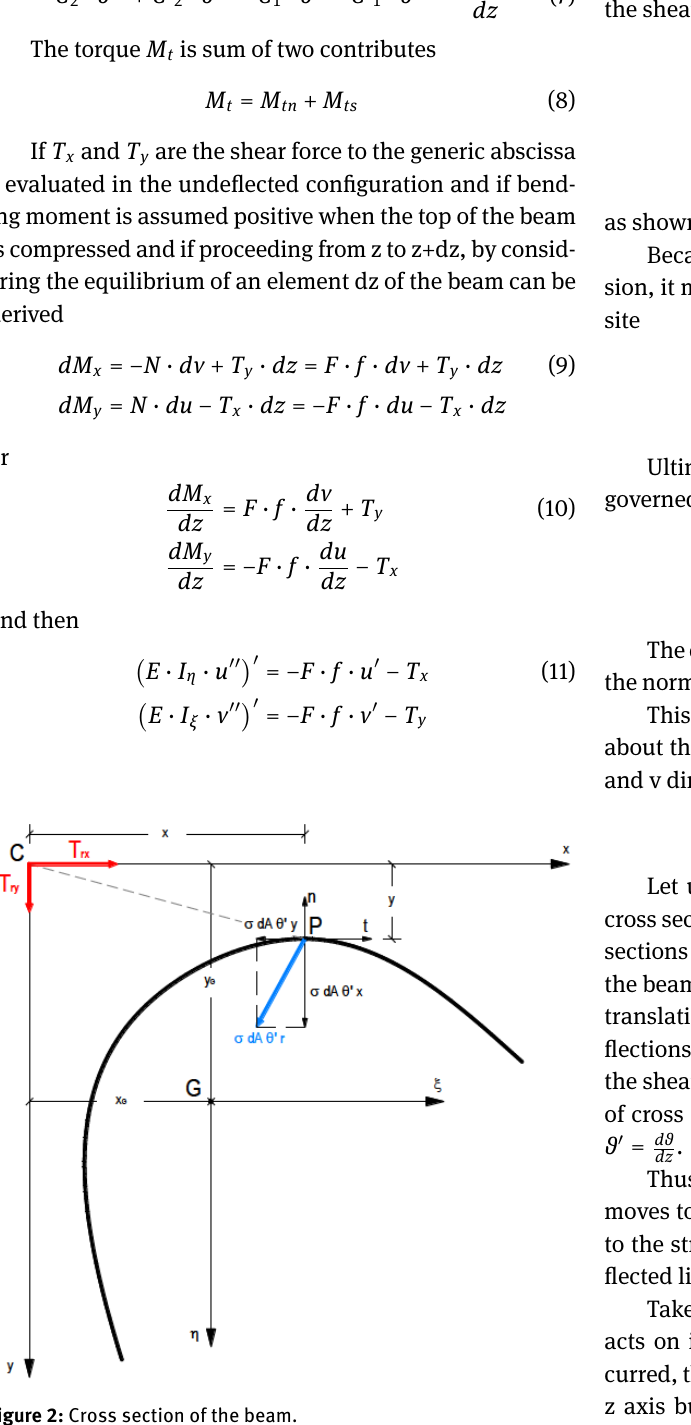
If the shear centre axis is forced to remains straight during torsion (for example by constraints applied